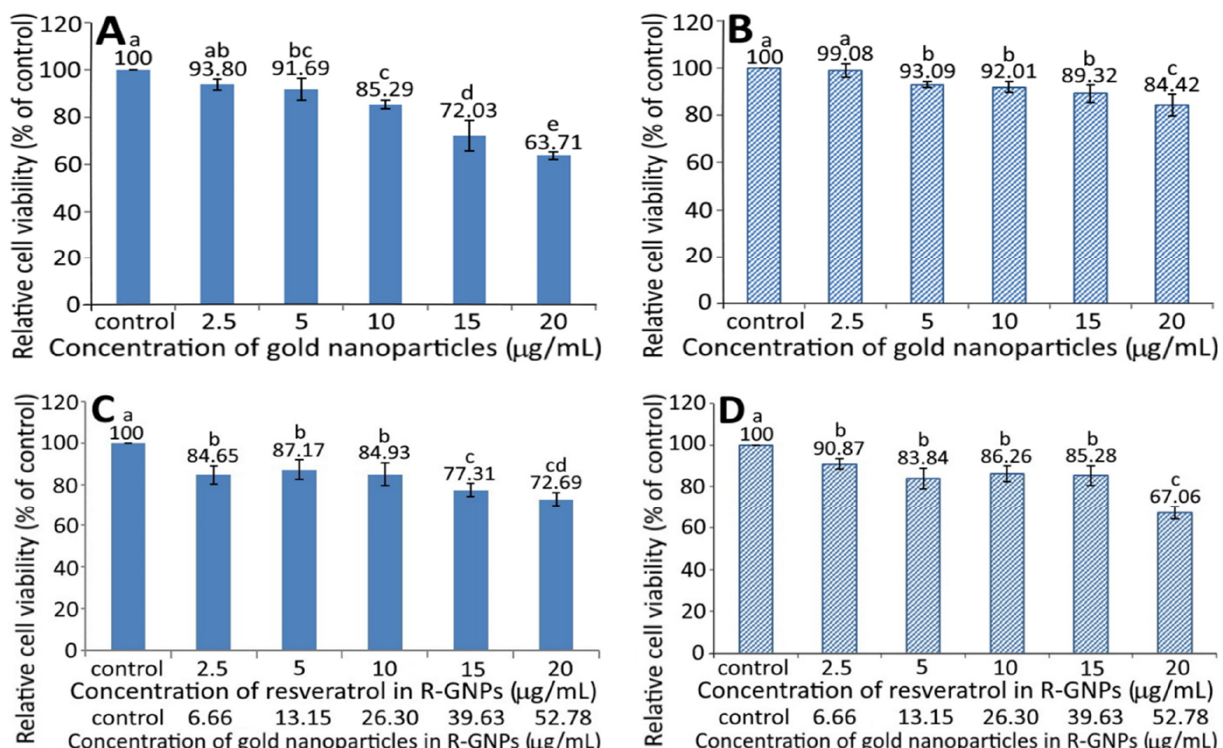
Figure 4. Effect of different concentrations of gold nanoparticles (GNPs) ( A , B ) and resveratrol-gold nanoparticles (R-GNPs) ( C , D ) on the growth of pancreatic normal cells MS1 ( A , C ) and pancreatic cancer cells BxPC-3 ( B , D ) after 48 h incubation as measured by MTT assay. Control represents that cells were incubated in RPMI medium only. Data are shown as mean ± standard deviation ( n = 3) and data with different small letters (a–e) are significantly different at p < 0.05.